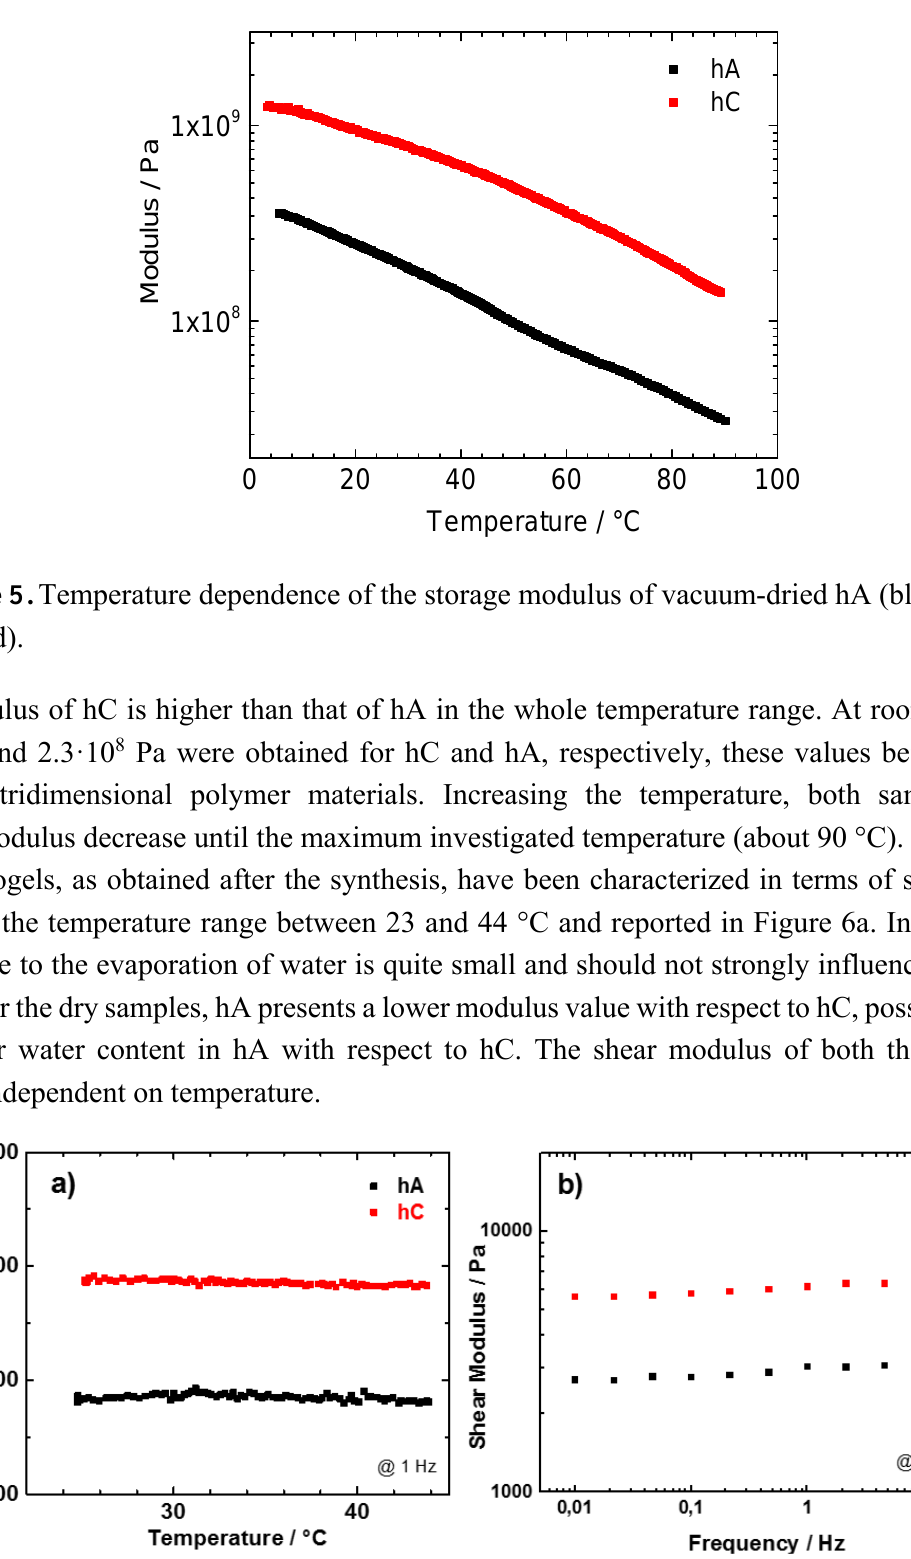
Figure 6. ( a ) Temperature; ( b ) frequency dependence of the shear modulus of pristine hA (black) and hC